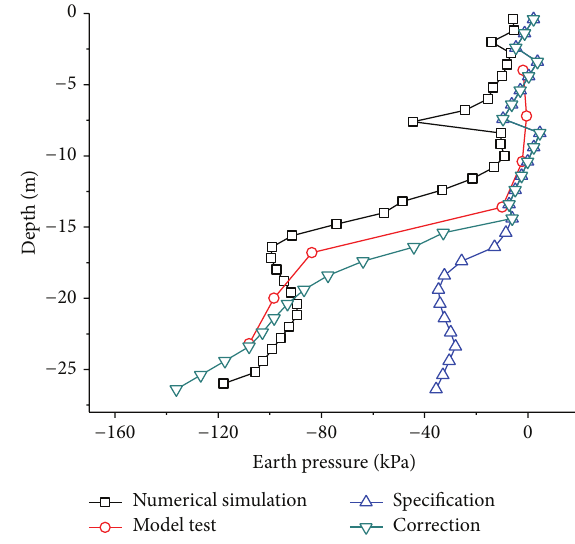
Figure 7: Earth pressure of front of front-row pile.